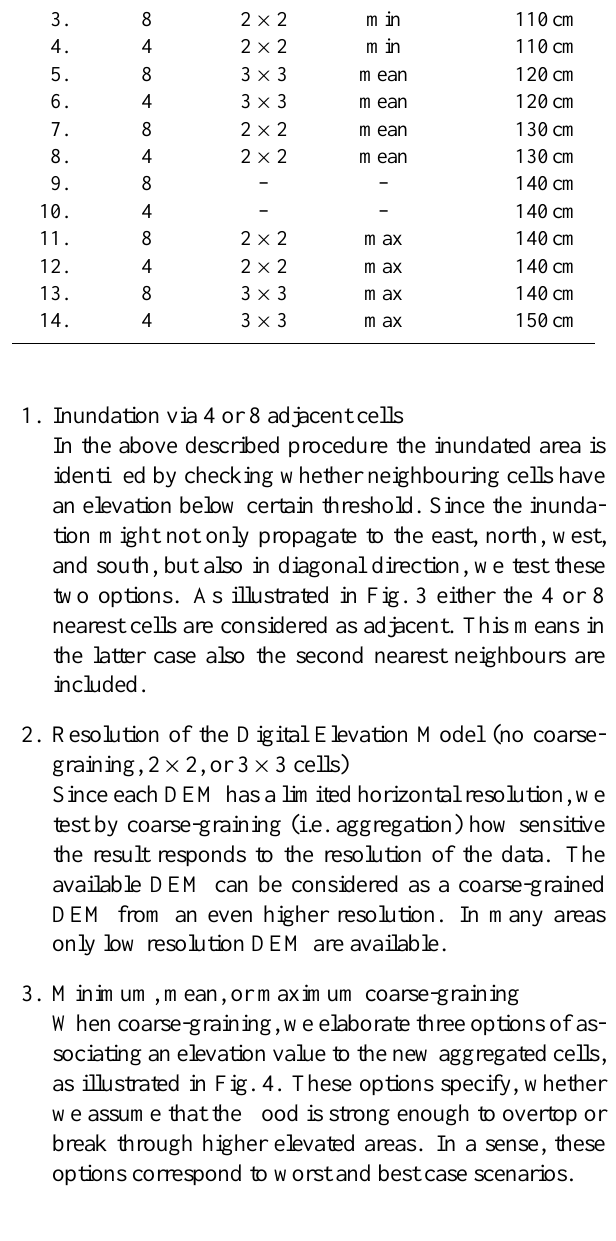
Fig. 3. Illustration of inundation via 4 nearest (left) or 8 nearest (right) neighbours. The former uses only nearest neighbours, i.e. at cell distance 1, the latter also includes second nearest neighbours, √ i.e. at cell distance